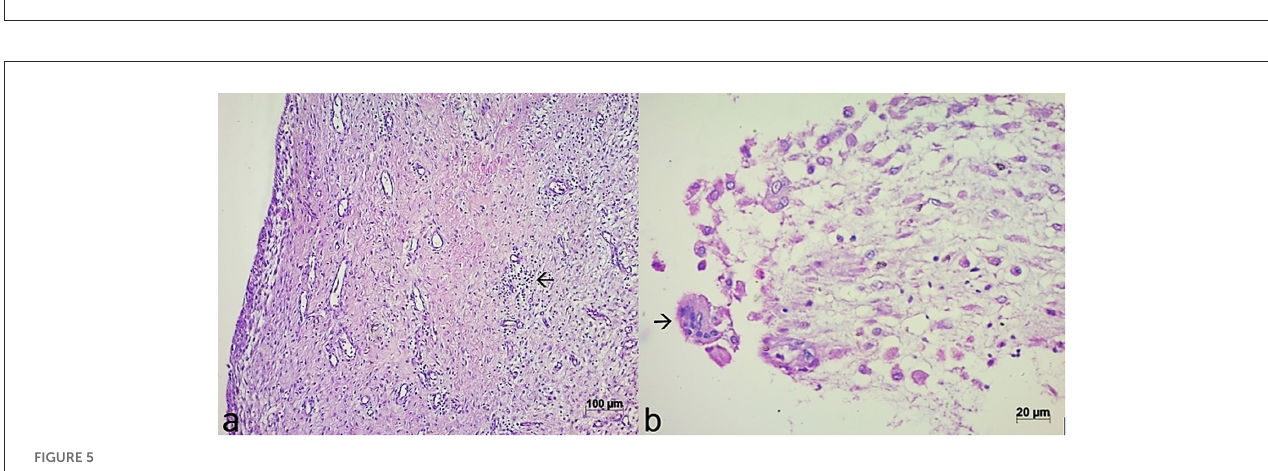
FIGURE4 Microscopic appearance of the induced membrane in chickens with cefazolin powder- loaded bone cement at seven (a) , 15 (b) , and 21 (c) postoperative days. (a) Fibrous and thin membrane showing low density (loose matrix), and an eosinophilic amorphous proteinaceous material at the center. HE, 10x. (b) Dense fibrous tissue (asterisks), narrow band of loose connective tissue (stars). HE, 5x. (c) Proliferation of loose connective tissue (asterisks), extensive area of cartilaginous tissue (dotted line), and skeletal muscle tissue (stars). HE, 10x.